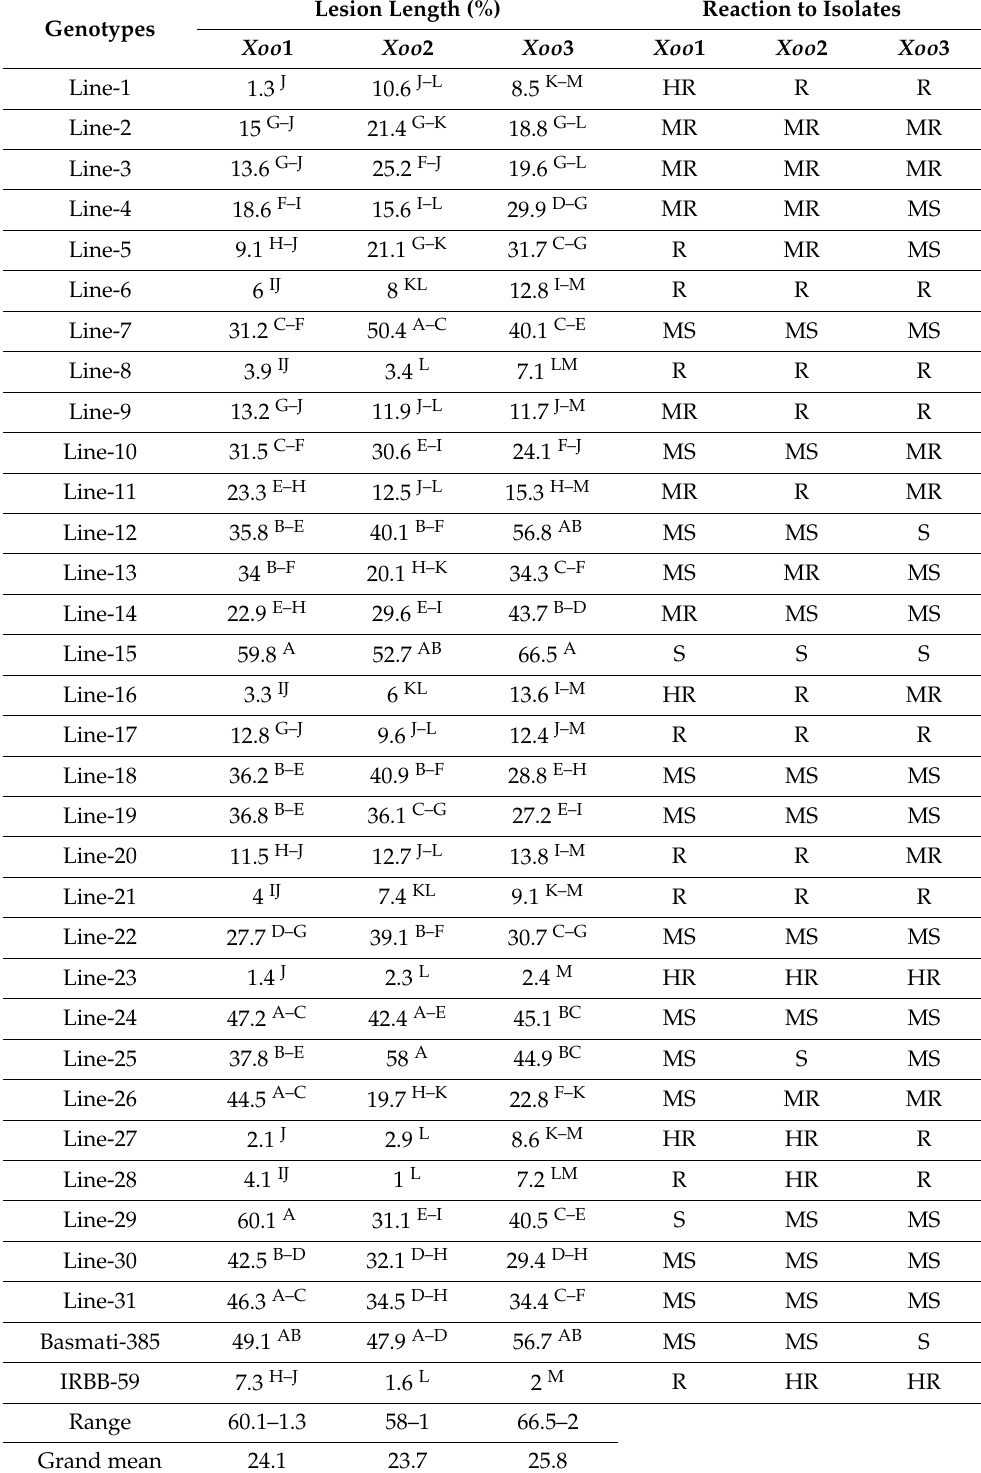
Table 2. Lesion percentage and responses of selected RILs of rice.